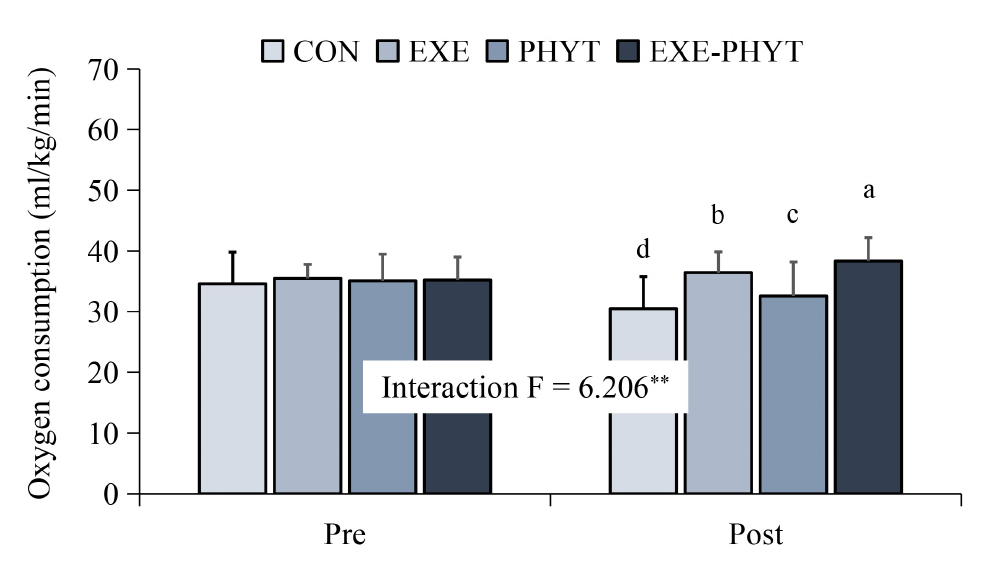
Fig. 4. Differences of cortisol and epinephrine concentrations between times and groups. In the figure, CON, control group; EXE, exercise group without phytoncide; PHYT, phytoncide group; EXE + PHYT, exercise + phytoncide group with phytoncide; ∗ , p < 0.05; ∗∗∗ , p < 0.001. Symbols a,b and c represent post-hoc test results. The absence of symbols indicates that there is no significant difference between groups. For reference, in the post-hoc test, the largest value is denoted by symbol a , and the smallest value is denoted by b , c or d . When symbols are combined, for example, the symbol ab means that the value of the group denoted by the symbol a and the value of the group denoted by the symbol b are almost the same.